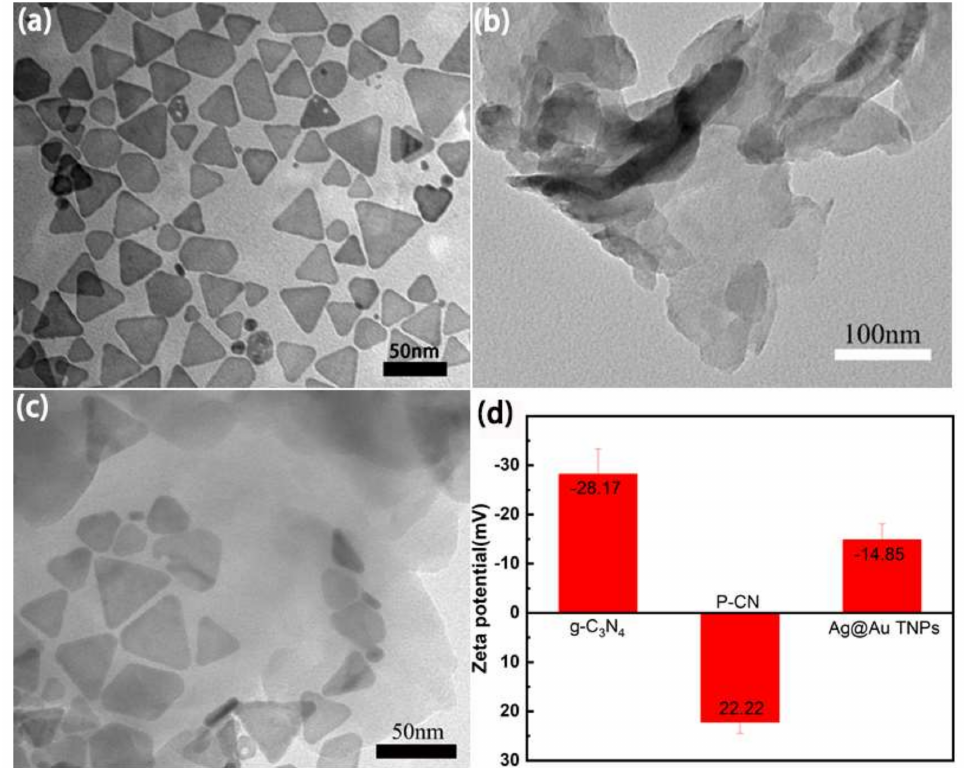
Figure 2. ( a ) TEM of Ag@Au TNPs stored in air condition after 180 days. TEM of P–CN ( b ) and Ag@Au TNPs/P–CN ( c , d ) zeta potentials of g-C 3 N 4 , P–CN, and Ag@Au